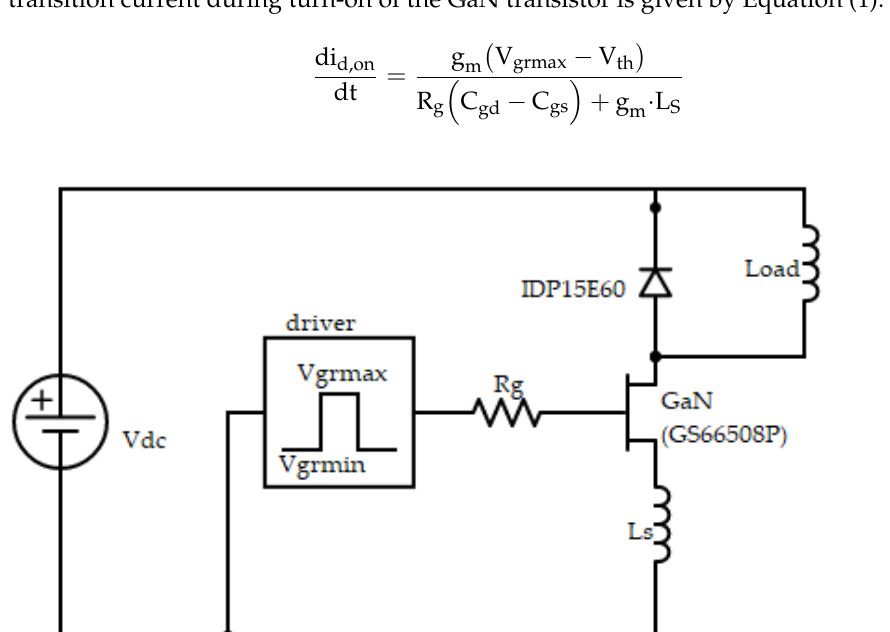
Figure 1. A simplified schematic of a transistor/diode switching cell in a buck configuration.